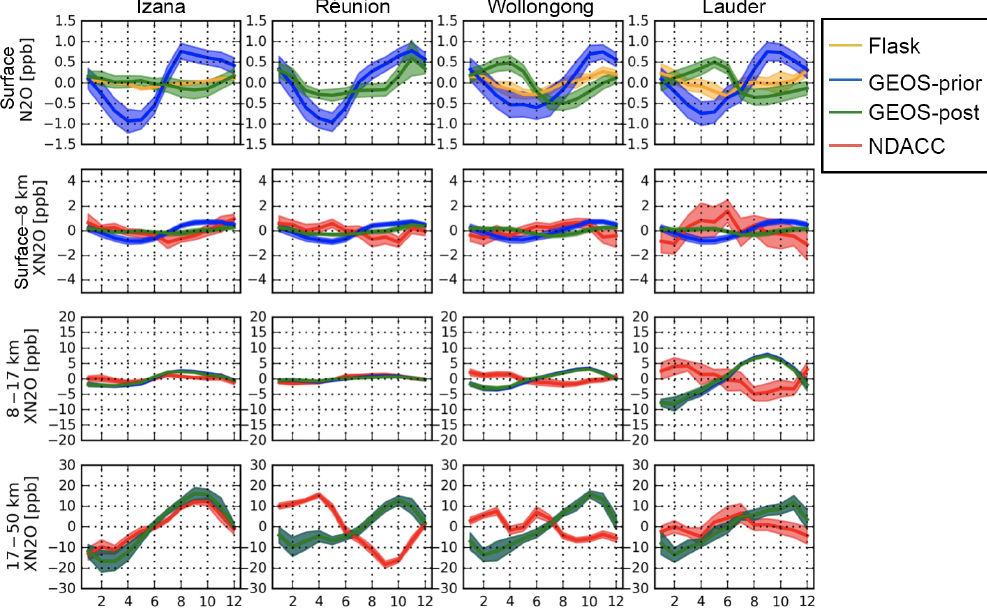
Figure 10. The N 2 O seasonal variations from the flask sample measurements and the a priori and a posteriori model simulations at the surface at Izaña, Réunion, Wollongong and Lauder (top panels). Second to fourth row panels show the X N NDACC measurements and the GEOS-Chem model simulations for three vertical ranges: surface–8, 8–17 and 17–50km. Note that the X N seasonal variations from the GEOS-Chem a priori and a posterior simulations are almost same for the high-altitude layers (8–17 and 2 O